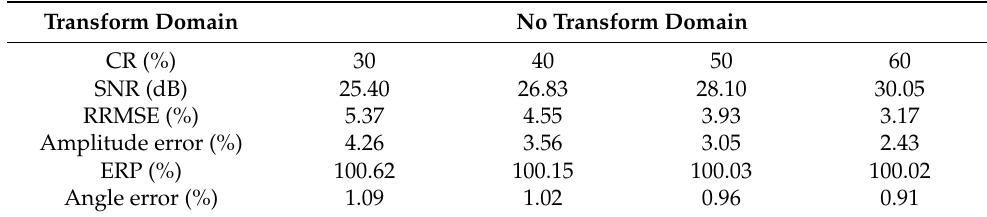
Table 5. Reconstruction results of the harmonic signals without a sparse transform.